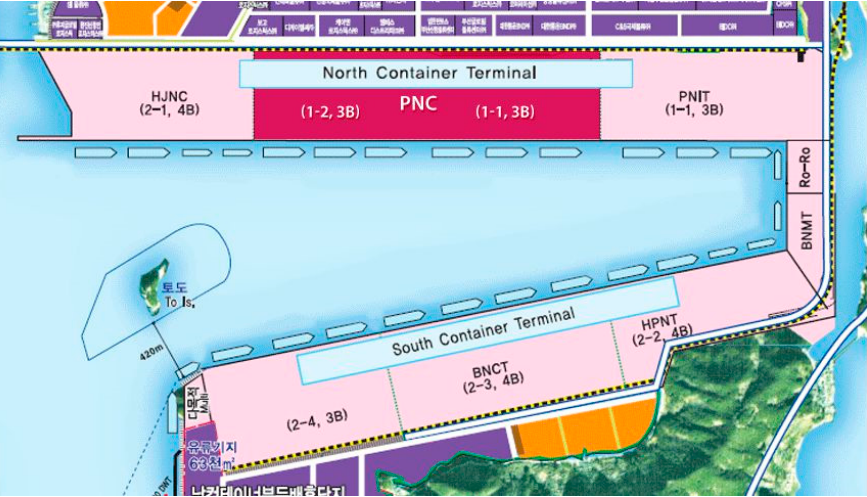
Figure 8. Busan New Port (BNP) container layout [28]. Table 3. Container movement rates between terminals in BNP [28].